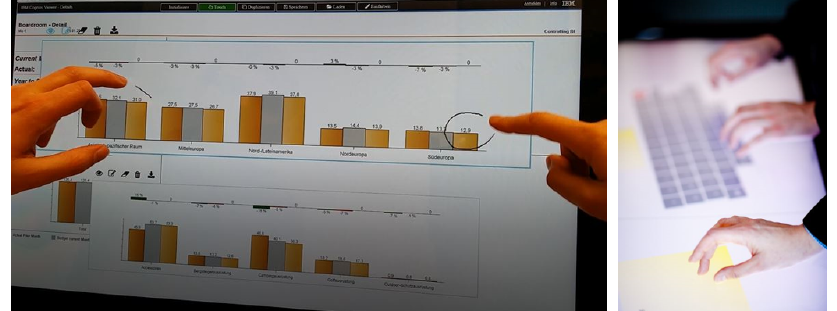
Figure 3. Multitouch and Multiuser Interaction.